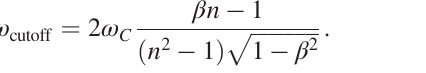
ffiffiffiffiffiffiffiffiffiffiffiffiffi p : ð 5 1 − β 2